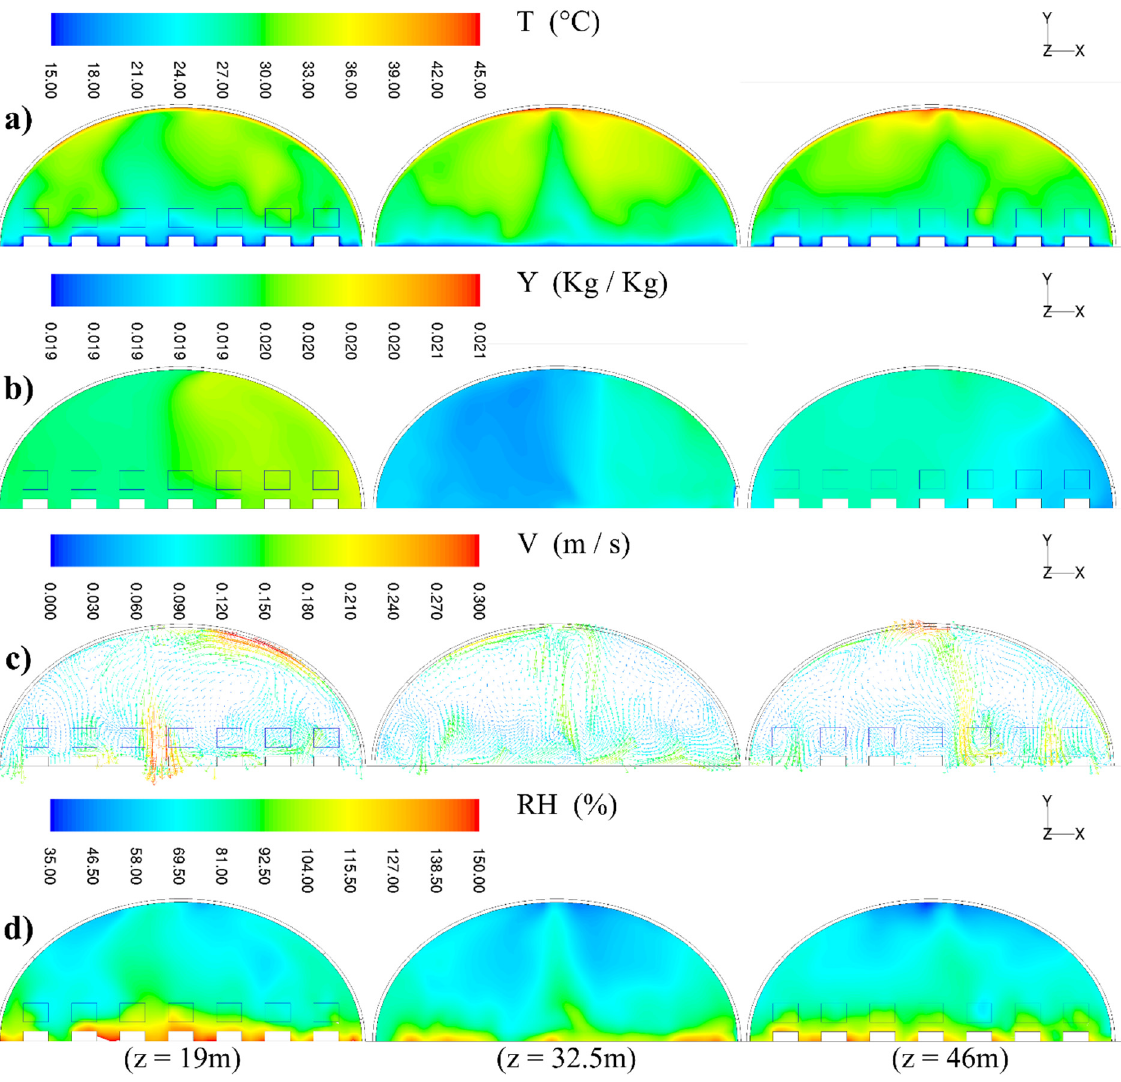
Figure 10. ( a ) Temperature, ( b ) Water mass fraction, ( c ) velocity, and ( d ) relative humidity distributions inside the greenhouse at distances z = 19 m, z = 32.5 m, z = 46 m from the door.